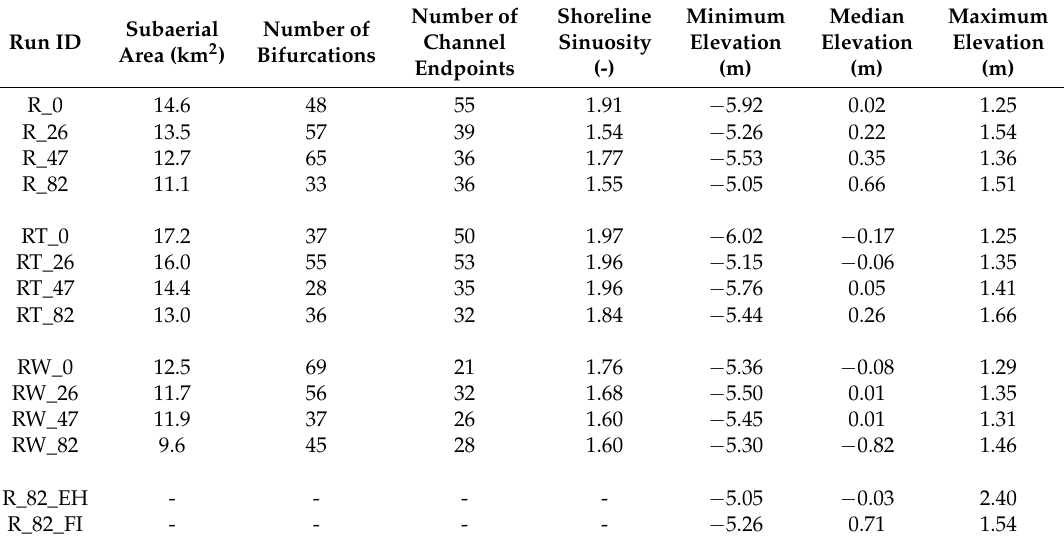
Table 2. Auxiliary descriptive statistics of delta coasts for modeling experiments used in this